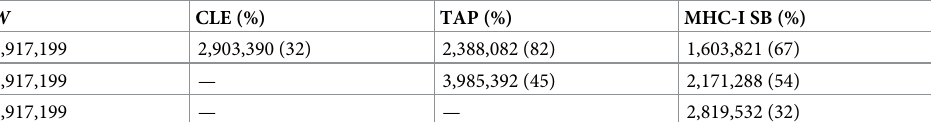
Table 3. Numbers of unique peptides and percentages for Trypanosoma cruzi related to selection steps: Protea- some cleavage (CLE) higher than or equal to 0.5, TAP transport (TAP) higher than or equal to 0 and MHC-I bind- ing (MHC-I SB) smaller than or equal to 0.5 for W = W 1 [ W 2 [ W 3 [ W 4 .